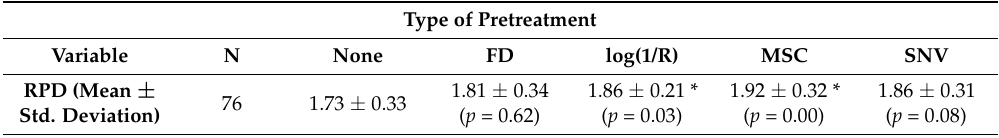
Figure 5. A boxplot of the RPD of the partial least squares regression (PLSR) model after including pretreatment in sample selection. FD denotes first derivative. log(1/R) denotes logarithmic function. MSC denotes multiplicative scatter correction. SNV denotes standard normal variate. Table 2. A comparison of different pretreatments in terms of residual predictive deviation (RPD) according to the analysis of variance (ANOVA) with a Games–Howell post-hoc test.